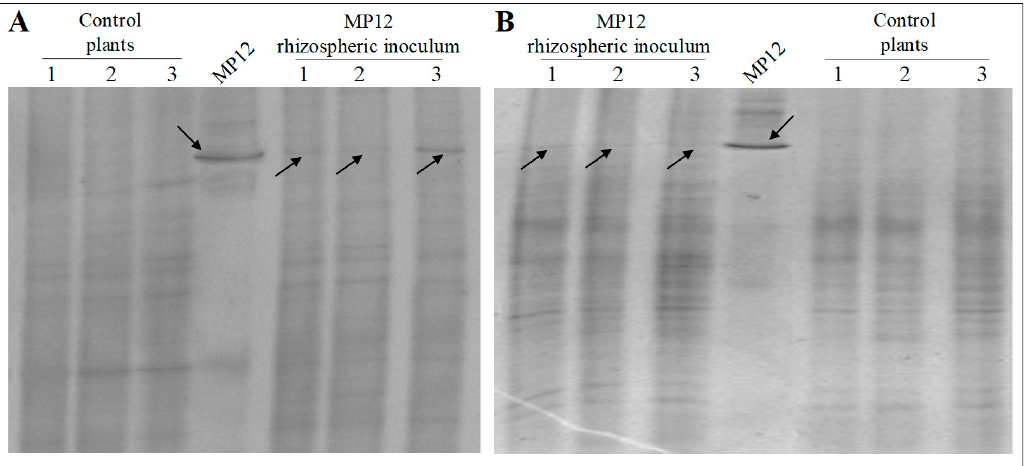
Figure 5. PCR-DGGE analysis of the rhizosphere of grapevine plants placed in the nursery field after ( A ) four hours and ( B ) one month after the MP12 rhizospheric inoculum. DGGE analysis of uninoculated plants (control plants) are also reported. Fragment amplified from P. protegens MP12 was used as reference.